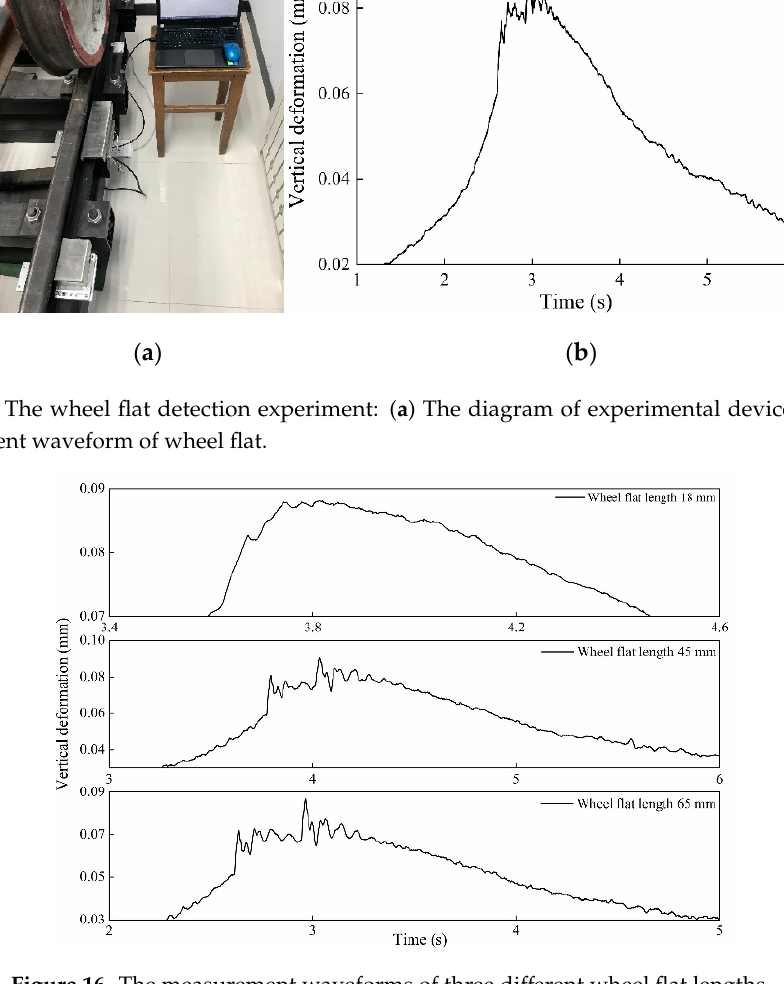
Figure 16. The measurement waveforms of three different wheel flat lengths. Table 2. Wheel flat measurement